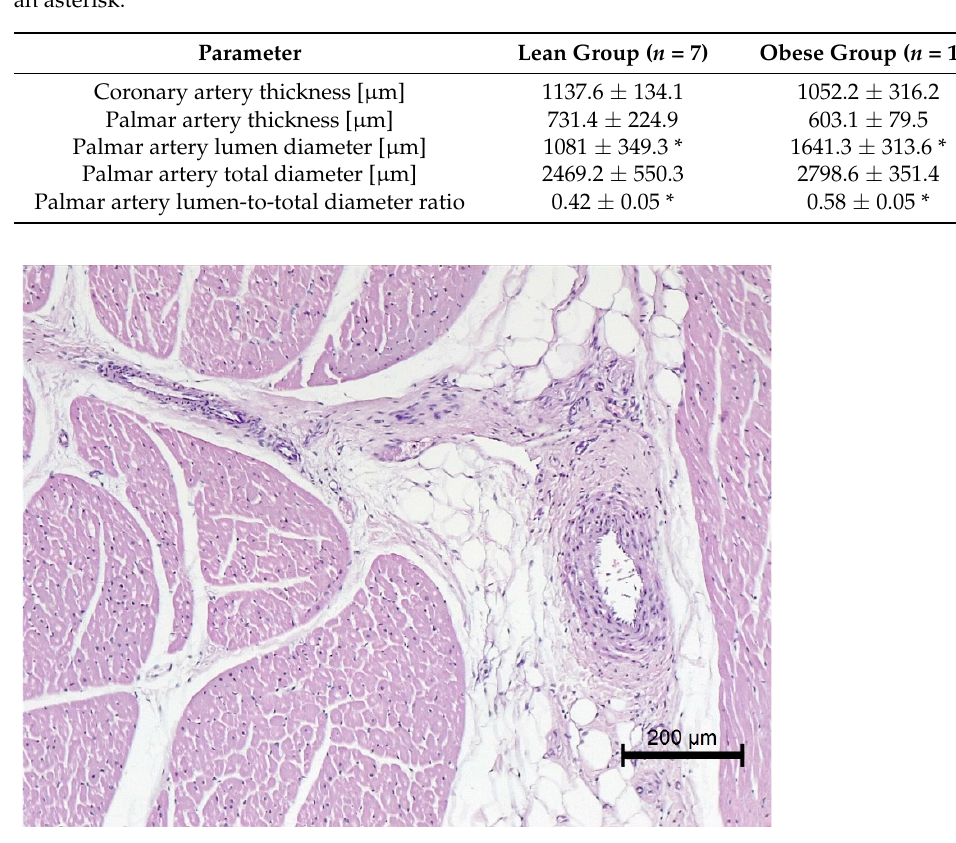
Figure 7. Microscopic image of the heart muscle specimen with coronary artery from a lean horse. Normal intraventricular coronary vessels; HE staining; 100×.